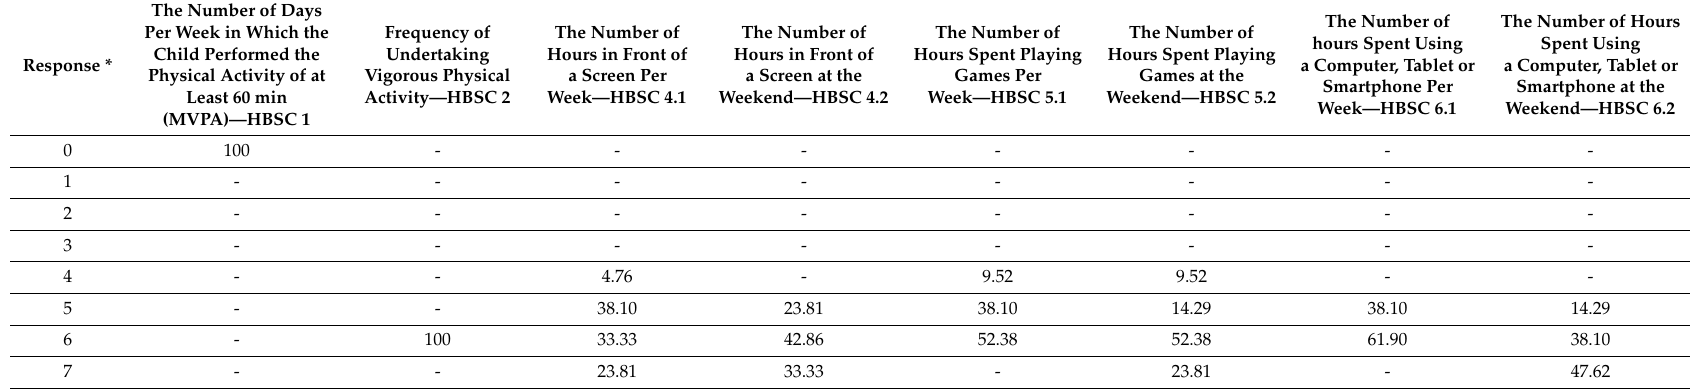
Table 9. Level of physical activity and sedentary behaviors. Percentage data on the number of people answering questions from the HBSC survey (%).